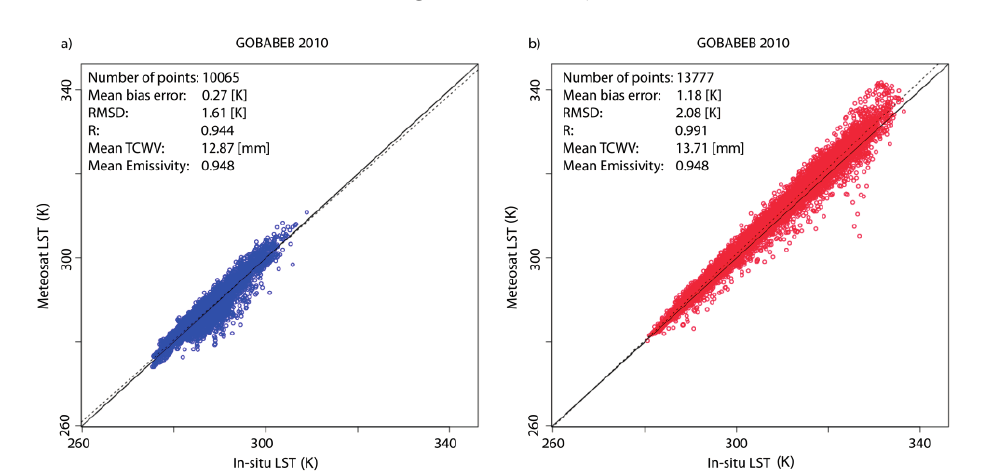
Figure 4. Comparison between in situ LST (KIT Gobabeb station, 2010) and Meteosat LST from the PMW for TCWVs < 35 mm: ( a ) Nighttime; ( b )